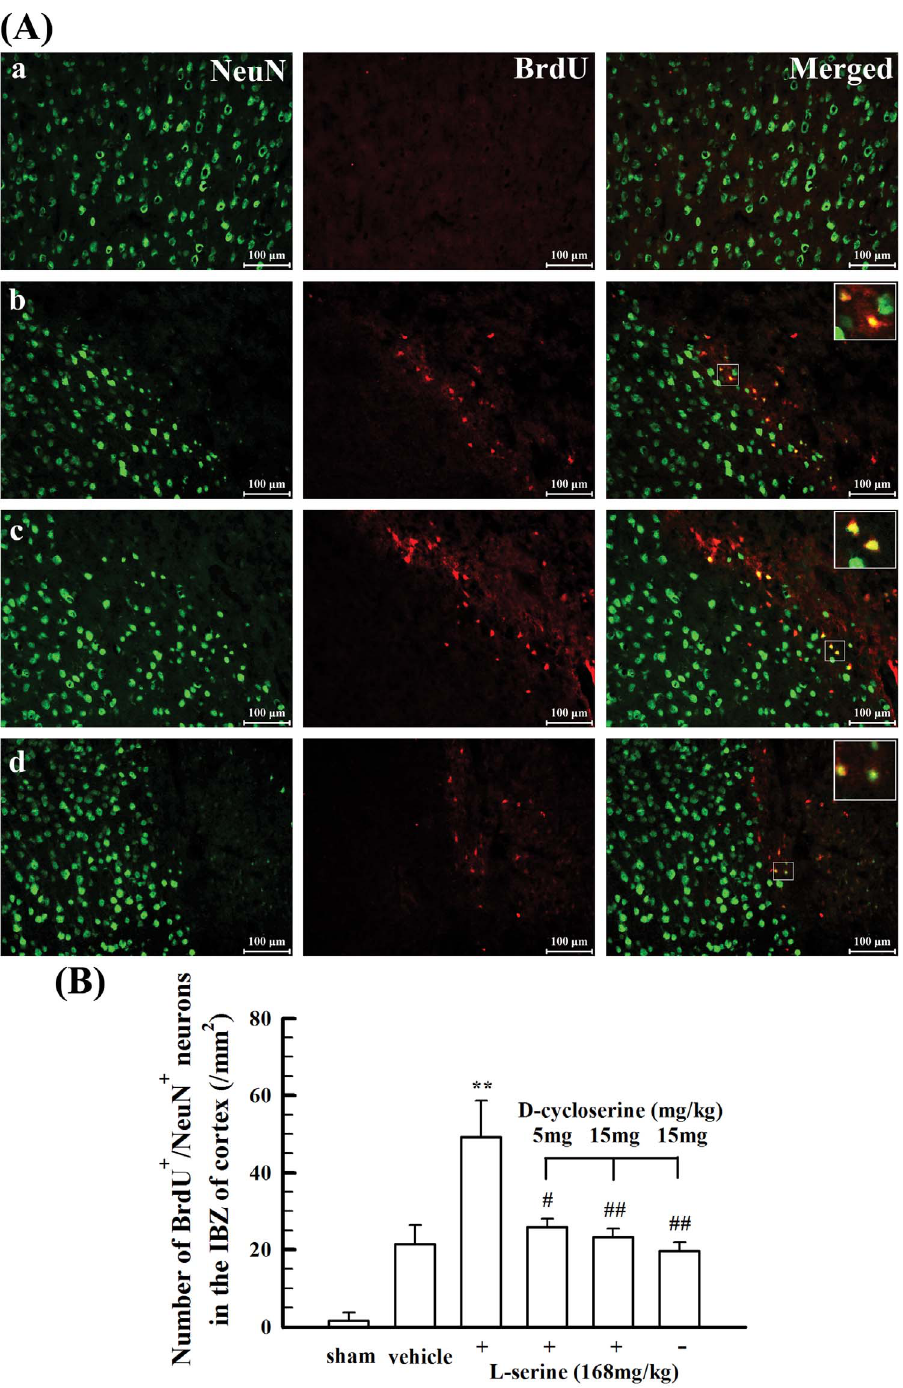
Figure 7. Effect of L-serine treatment on the new-born neurons in the IBZ of cortex 14 days after pMCAO. (A) Representative examples of BrdU- and NeuN-positive cells: a, sham-operated group; b, vehicle group; c, L-serine (168 mg/kg) treated group; d, L-serine (168 mg/kg) and D- cycloserine (15 mg/kg) treated group. (B) Mean values of the number of BrdU + /NeuN + neurons in the IBZ of cortex (n=4–6). ** p , 0.01 vs . vehicle group; # p , 0.05, ## p , 0.01 vs . L-serine-treated group.